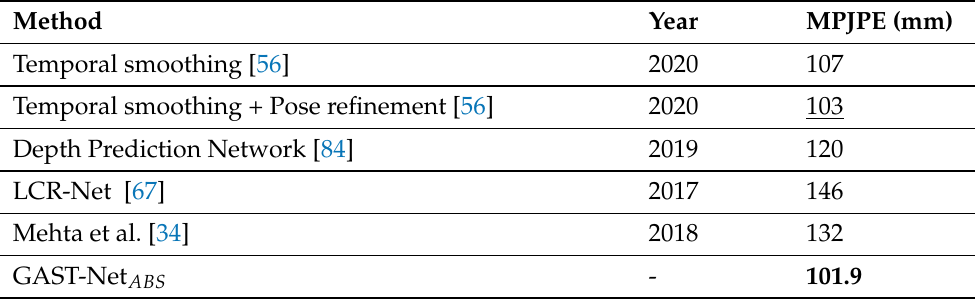
Table 4. MPJPE of the relative poses on the MuPoTS-3D dataset. The best is in bold, the second best is